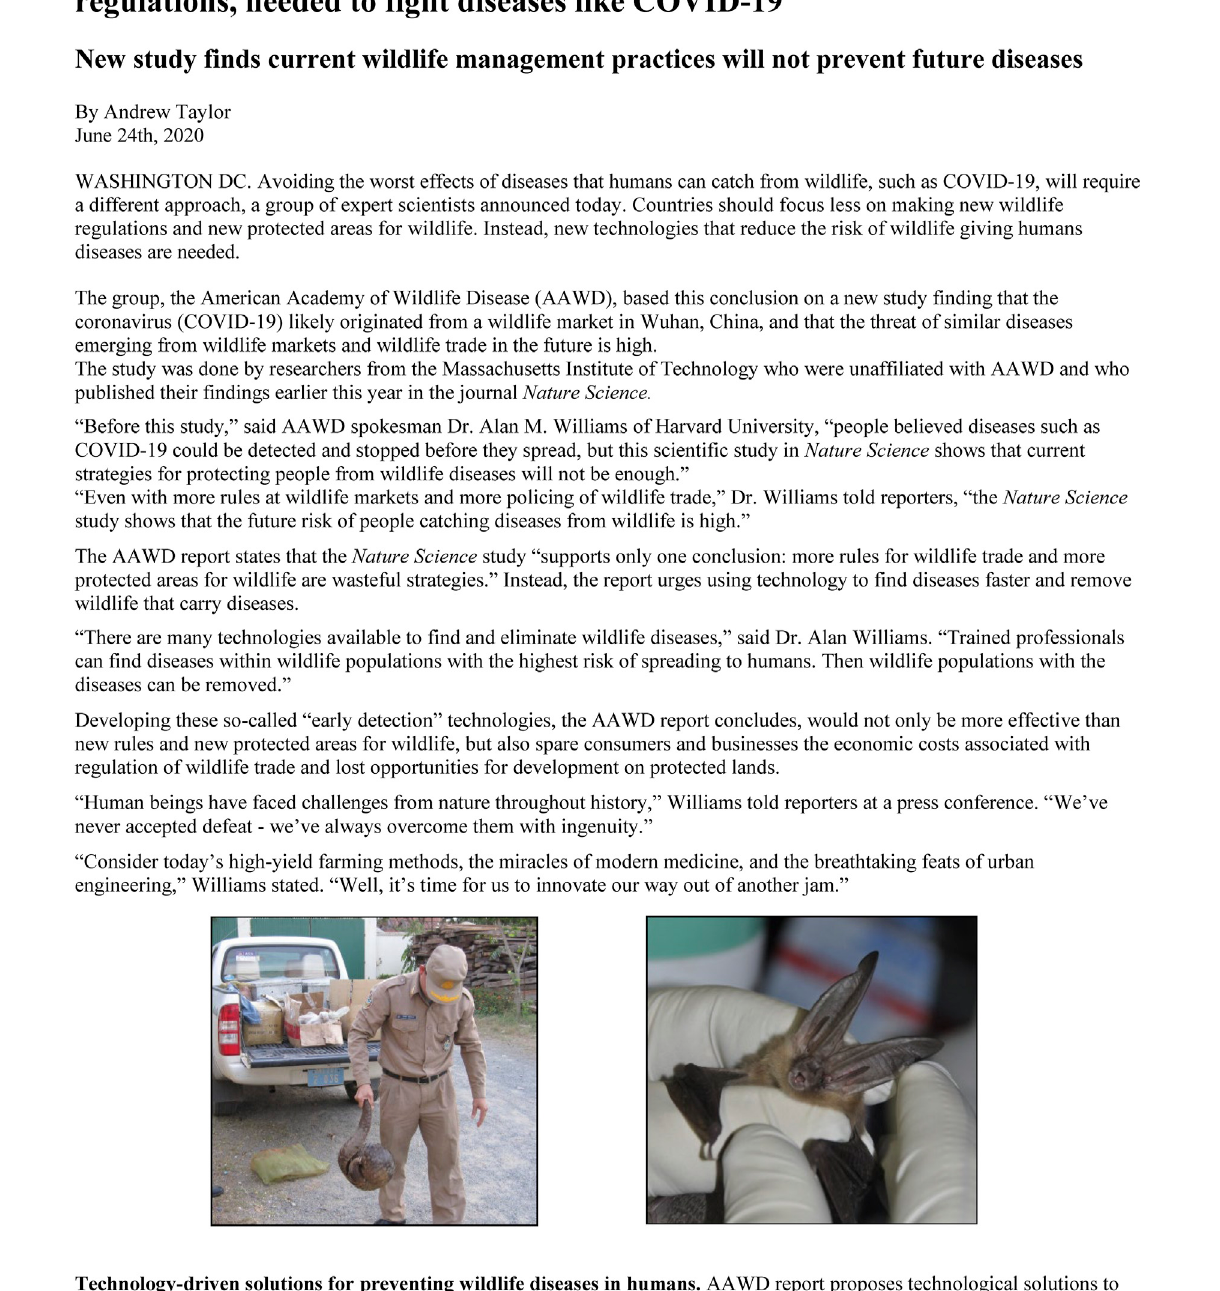
Frontiers in Communication |